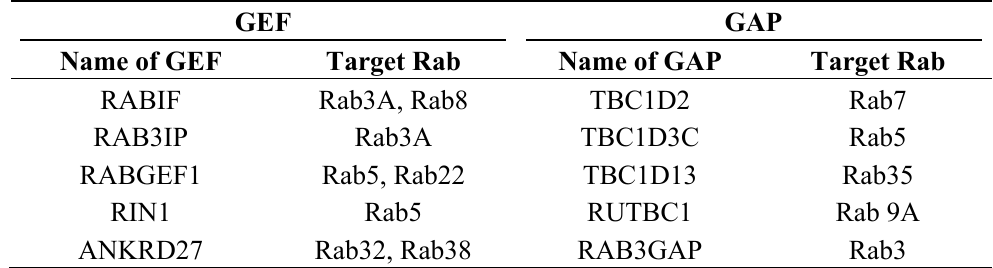
Table 1. A few examples of Rab-guanine nucleotide exchange factors (GEFs) and Rab-GTPase activating proteins (GAPs) and their target